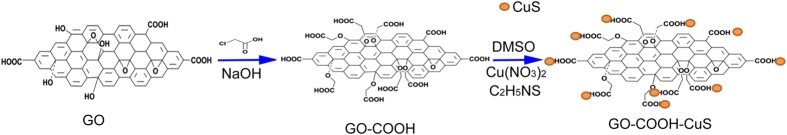
Synthetic route of GO-COOH and GO-COOH-CuS nanocomposites.